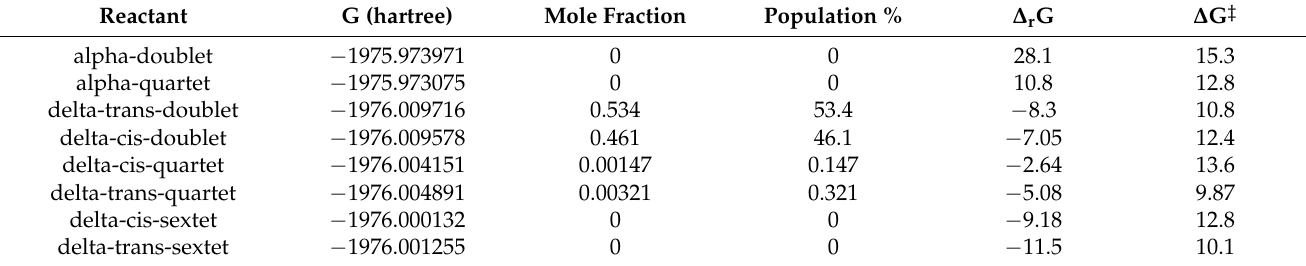
Table 6. Boltzmann distribution for radical conformers present in reaction coordinate III for the β